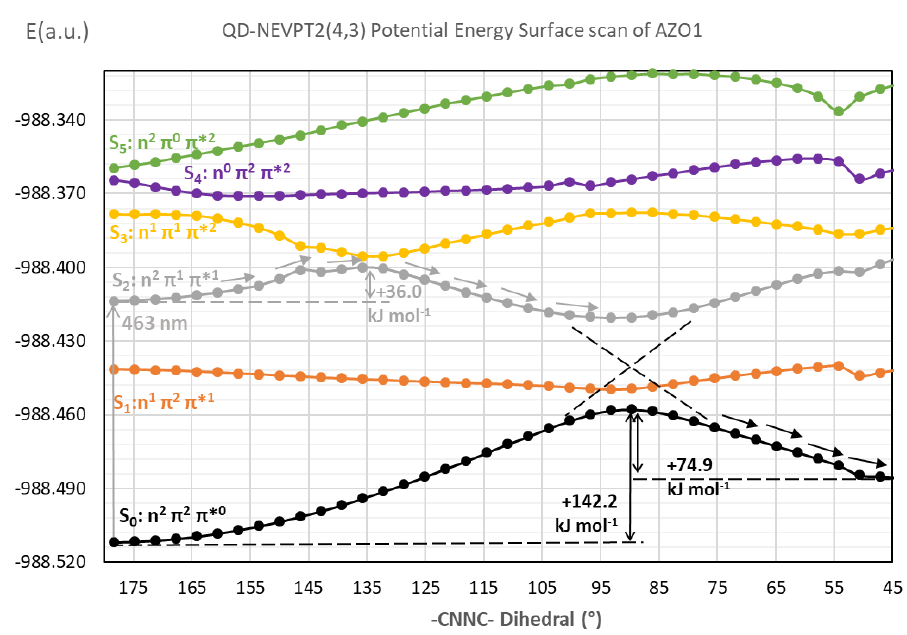
Figure 7. QD-NEVPT2(4,3)//SA6-CASSCF (4,3)/def2-TZVP potential energy surface scan of the six lowest lying singlet states of AZO1. The S 2 and S 3 have an avoided crossing at approximately (CNNC) = 139° and some 8.6 kcal/mol above the S 2 minimum.